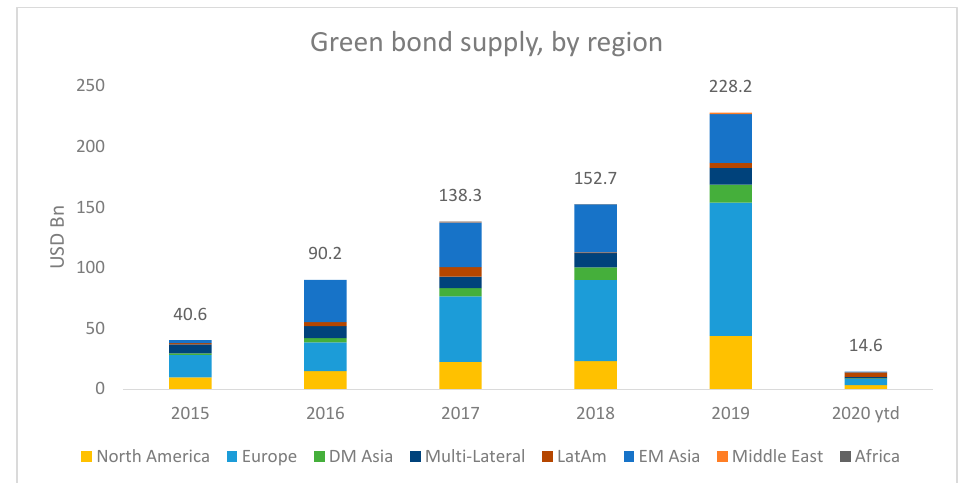
Figure 2. A market with a more diversified pool of issuers. Source—Dealogic, Bloomberg as of